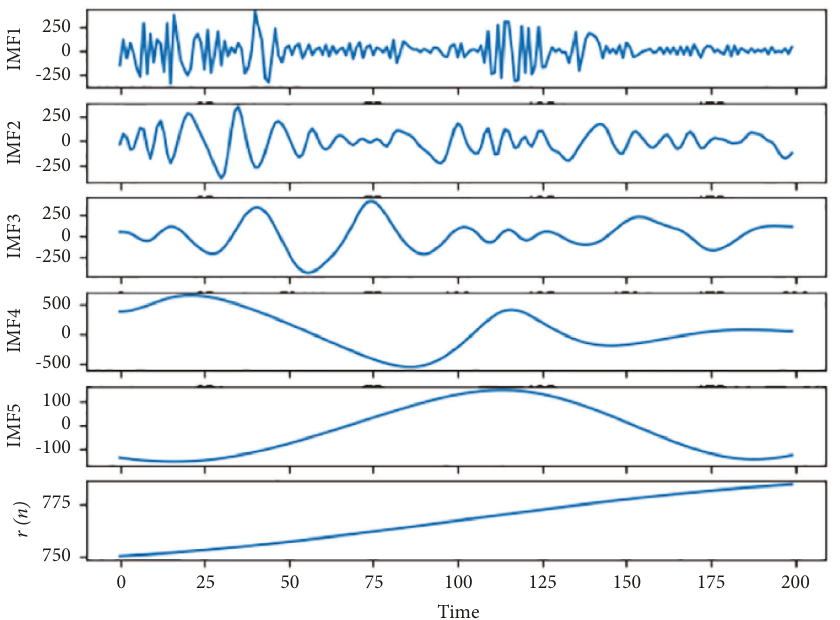
Figure 3: Each subsequence diagram after CEEMDAN